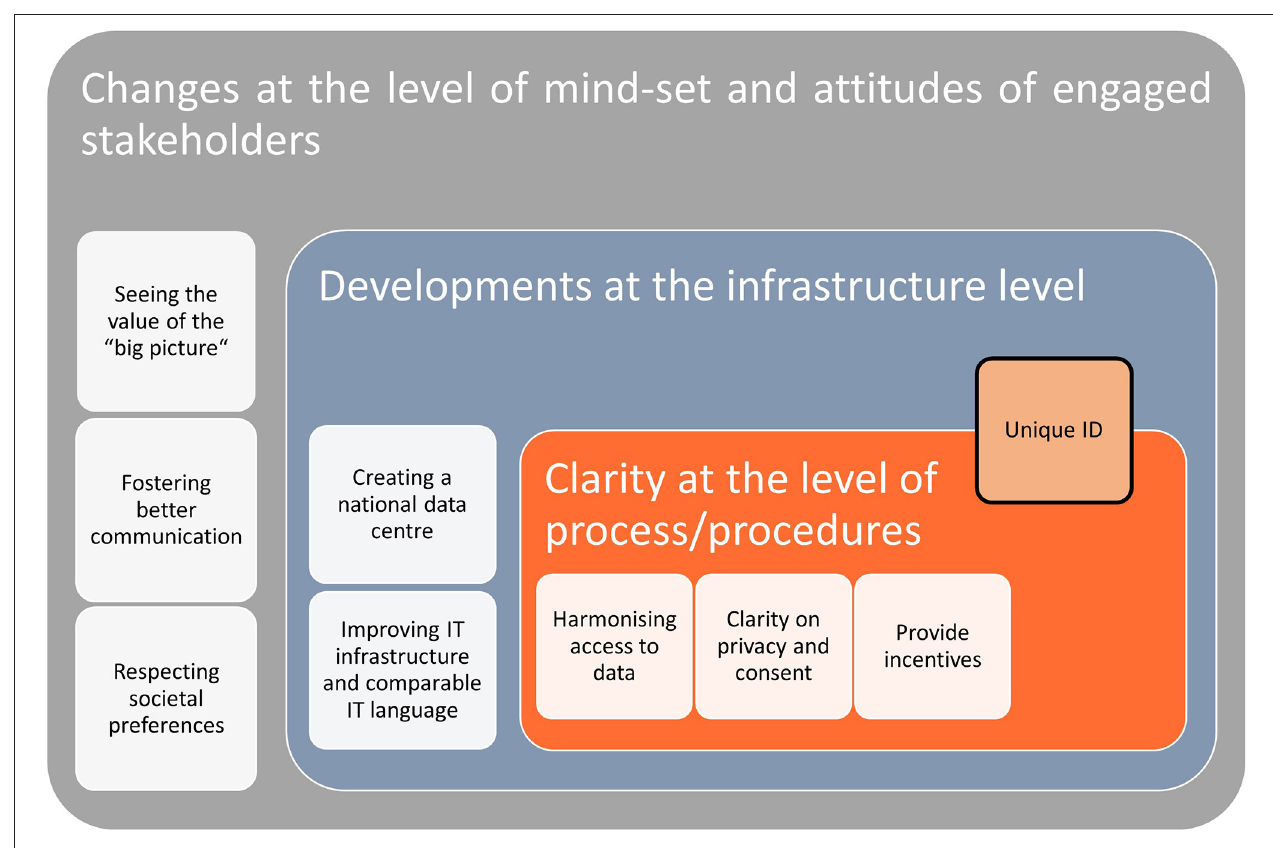
FIGURE 1 | Overview of the recommendations and their different